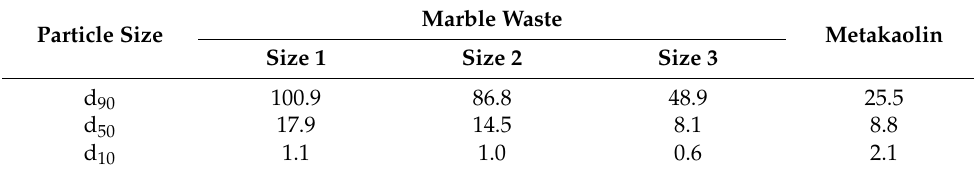
Table 1. Particle size ( µ m) of raw materials.